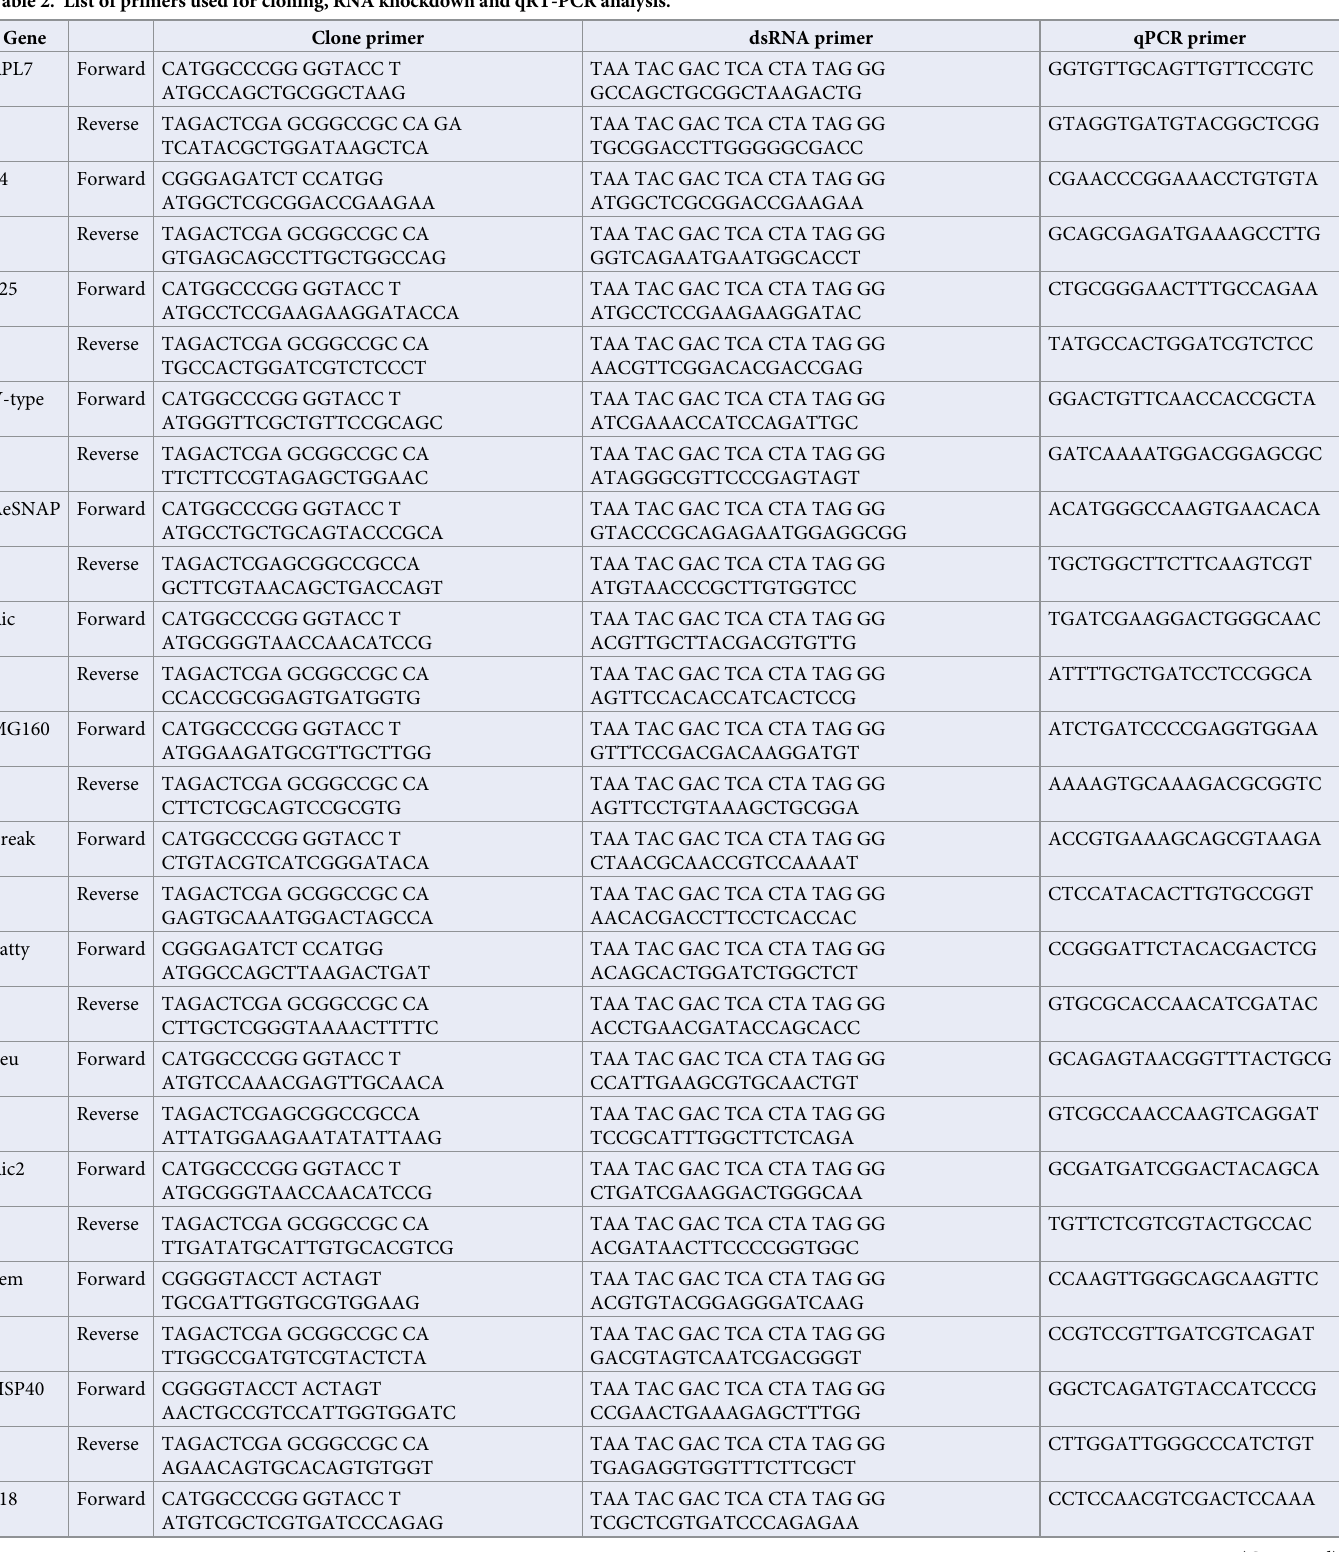
Table 2. List of primers used for cloning, RNA knockdown and qRT-PCR analysis.